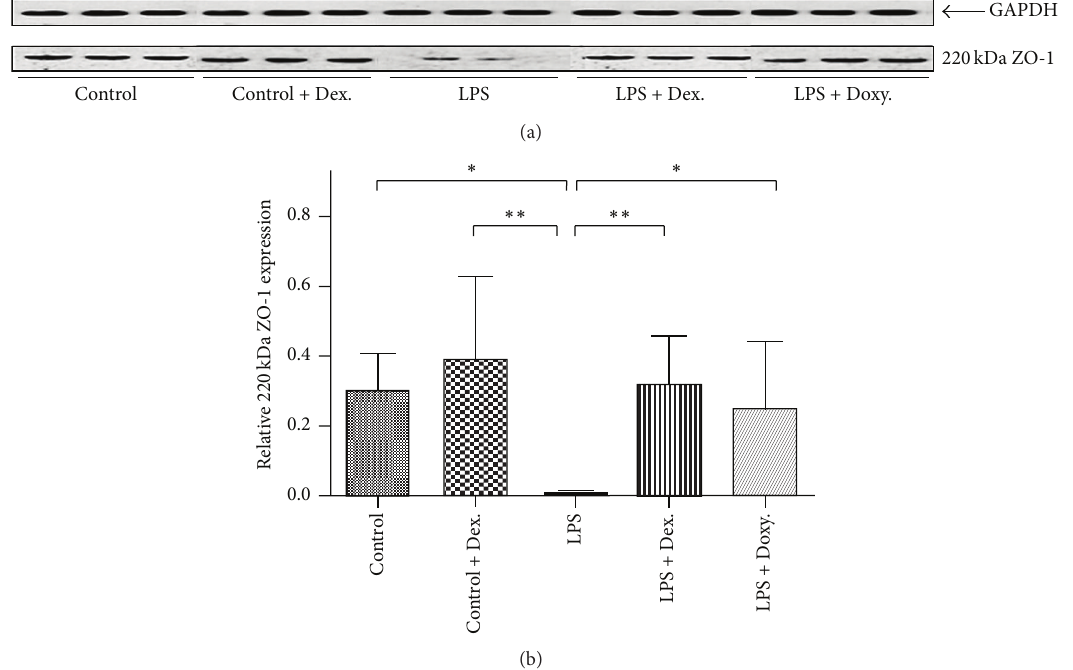
Figure 4: Immunoblotting of ZO-1. Proteins of aortic tissues were extracted from each of the indicated groups and immunoblotted for ZO-1 as described in the method. (a) One representative image data of immunoblotting. GAPDH was used as loading control. Each group was loaded in triplicate. (b) Densitometric analysis data of the relative expression of ZO-1 (mean ± SD, 𝑛 = 8 ). ∗ 𝑝 < 0.05 ; ∗∗ 𝑝 < 0.001 .